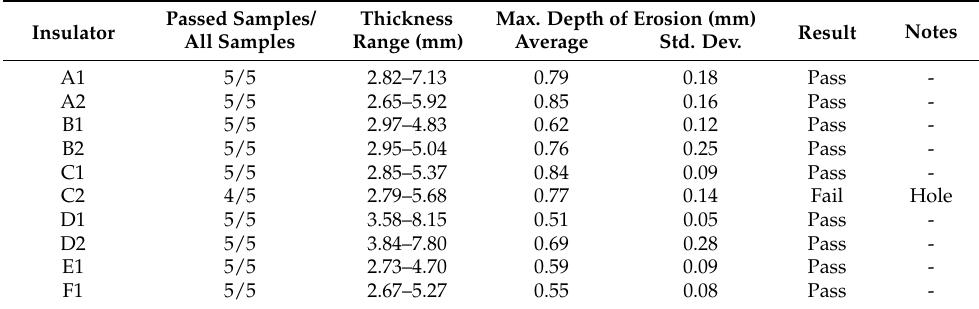
Table 2. Analytical results of inclined plane test for the HTV silicone rubber with ATH filler material of all available composite